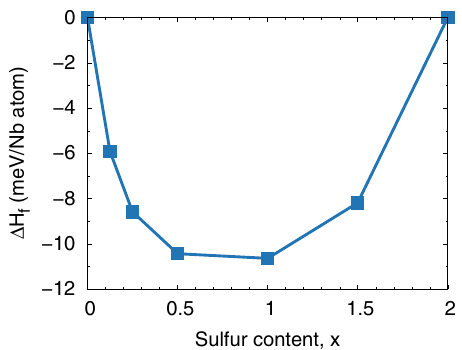
Fig. 2 Formation enthalpy as a function of S content, x , in NbS x Se 2 − x . Calculations are performed using a (4 × 4 × 1) supercell of the